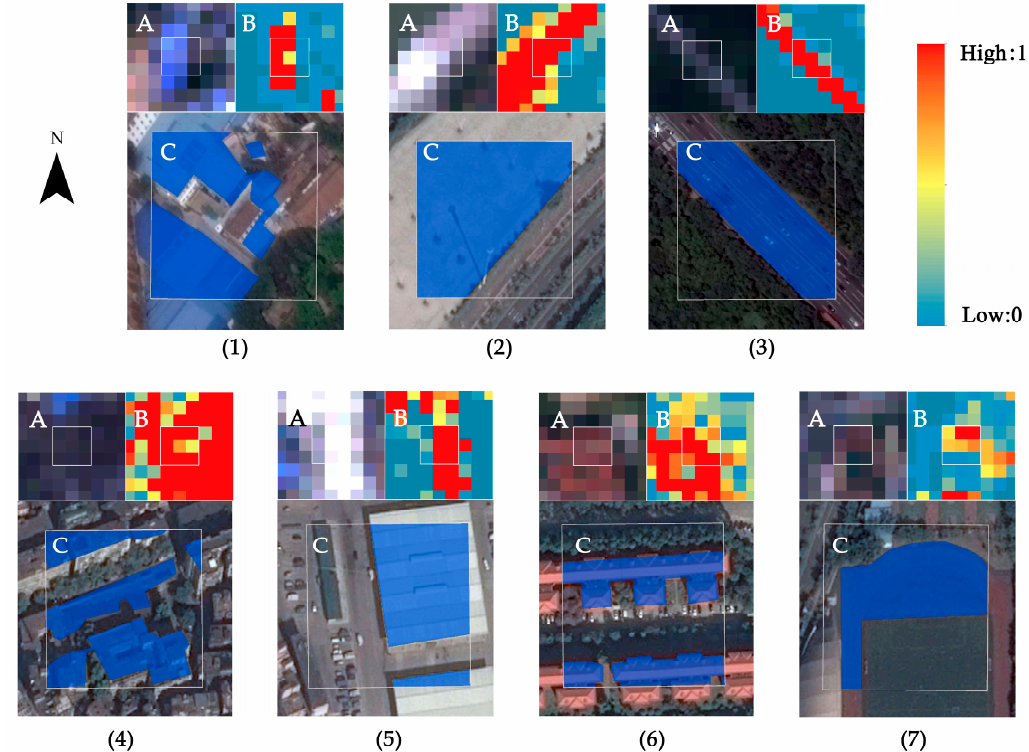
Figure 9. Selected reference sample of each IS type. ( 1 ) blue steel; ( 2 ) cement; ( 3 ) asphalt; ( 4 ) other impervious surface; ( 5 ) other metal; ( 6 ) brick; ( 7 ) plastic; ( A ) Reference samples on Landsat 8 (Band4/3/2); ( B ) Estimated detailed classification results of ISA; ( C ) Reference samples on Google earth, each IS area was highlighted in blue.